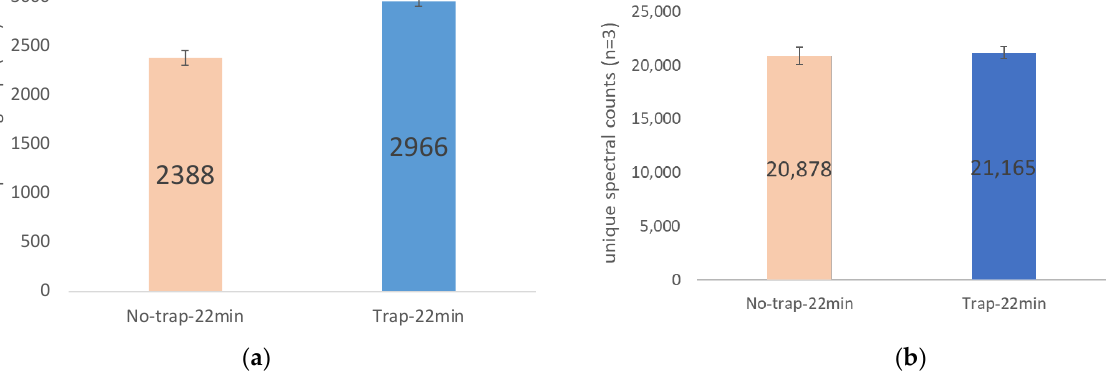
Figure 11. Trap column and proteome coverage. Comparisons of proteome coverage were made with and without a trap column loaded with 200 ng of HeLa digest ( a ) identified protein groups; ( b ) unique spectral counts. The mean and standard deviation of triplicate injections are shown for the inclusion and exclusion of a trap column.